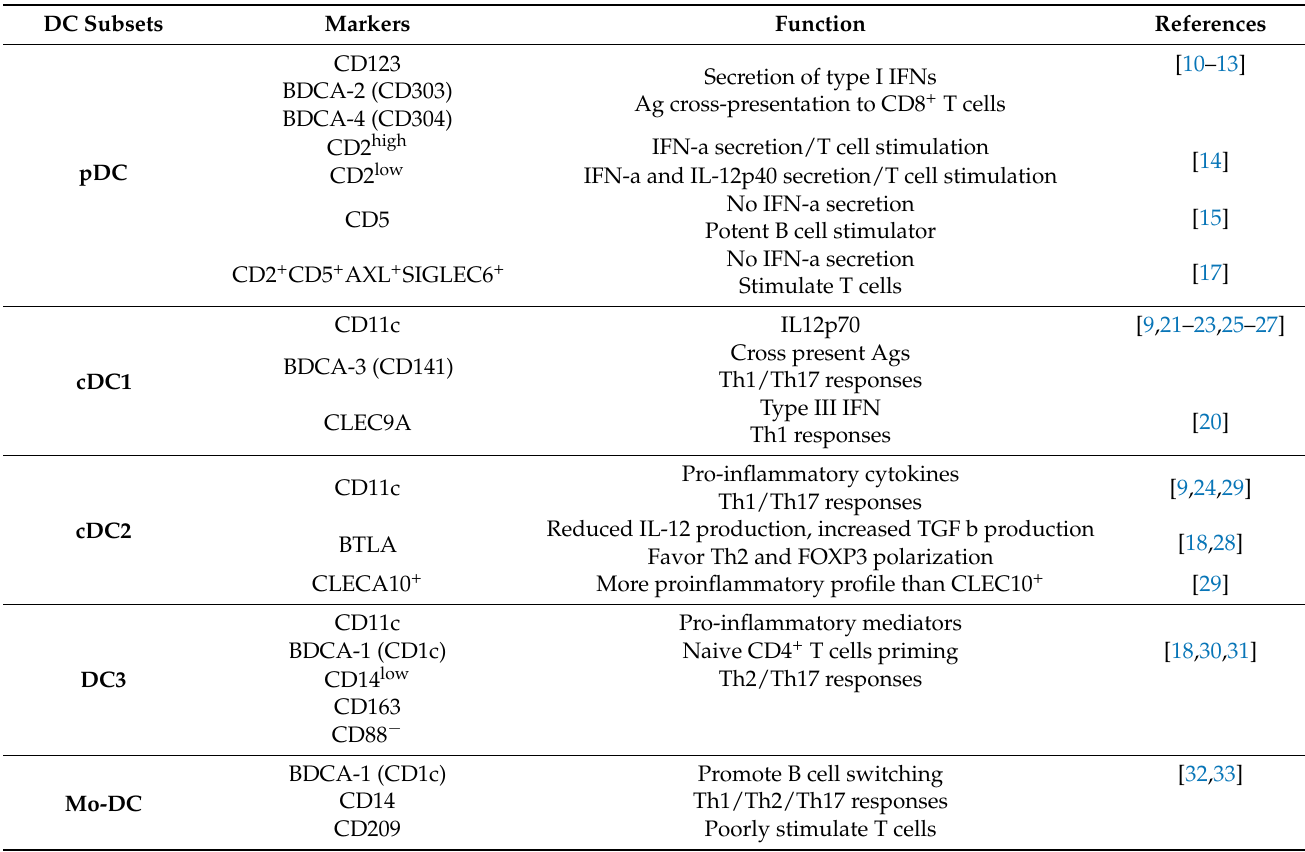
Table 1. Human DC markers and